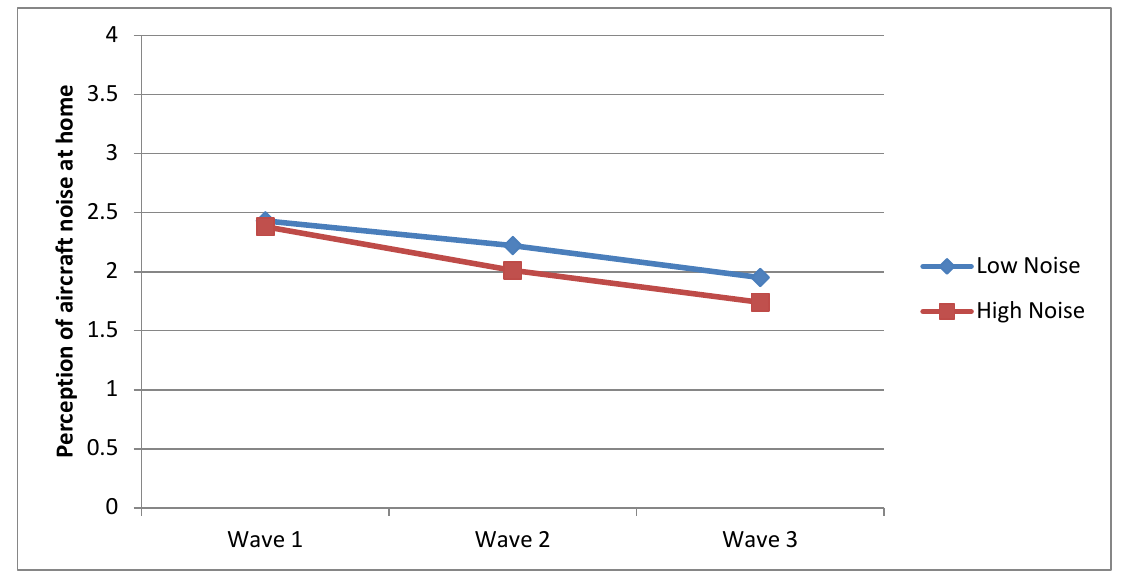
Figure 4. Perception of aircraft noise at